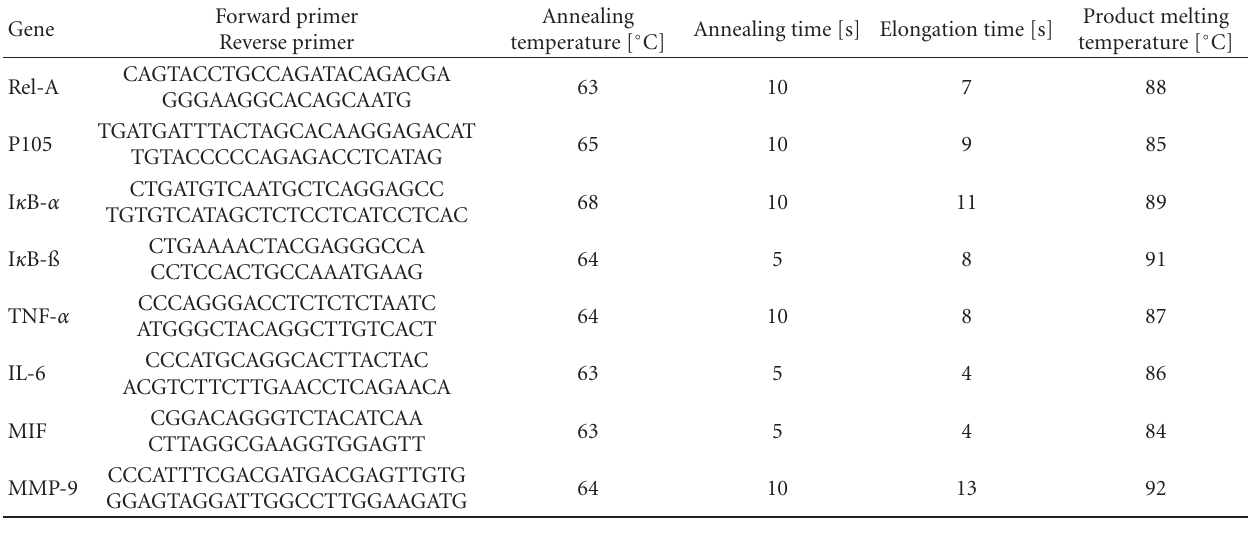
Table 1: Primer composition and PCR protocols.